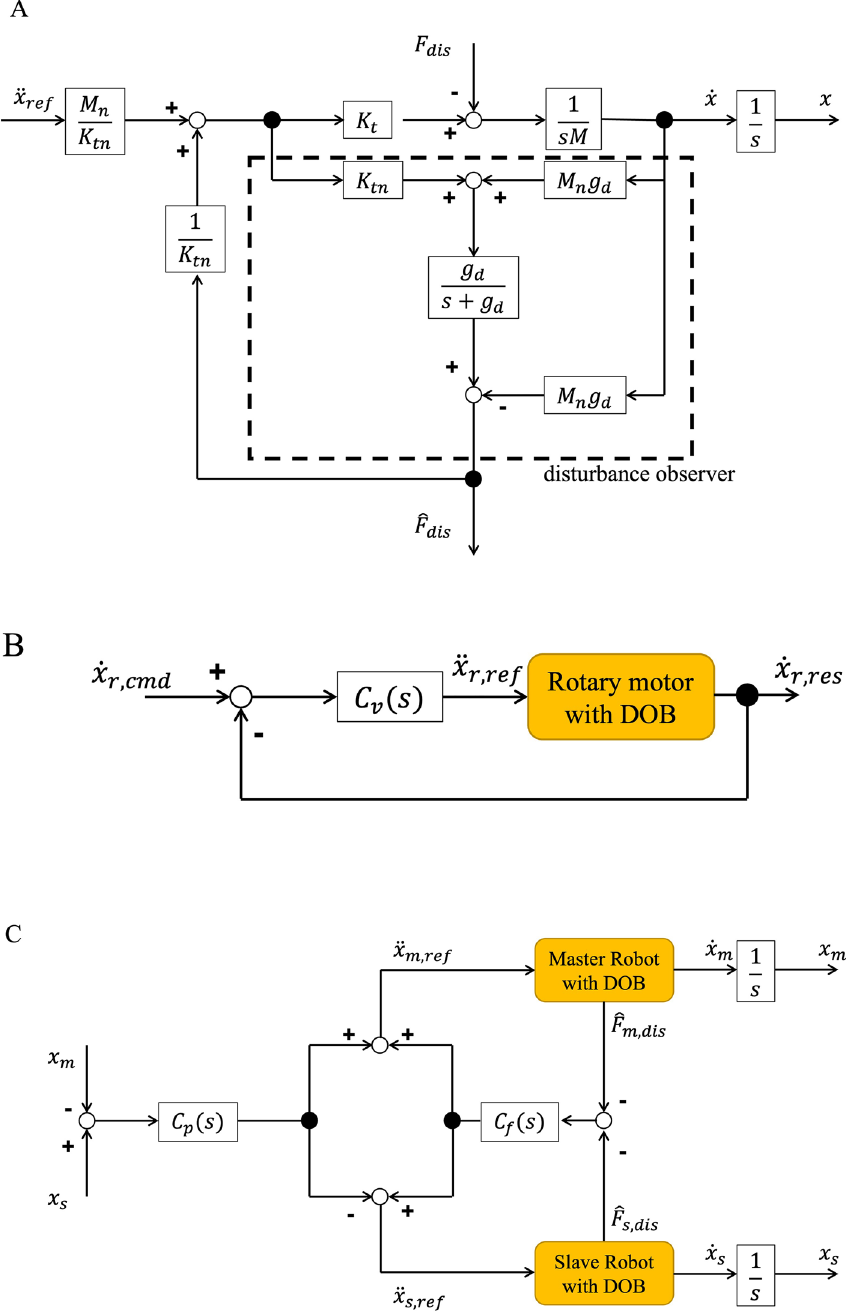
Figure 2. Block diagram. ( A ) Block diagram of the disturbance observer. ( B ) Block diagram of the velocity control. ( C ) Block diagram of the bilateral